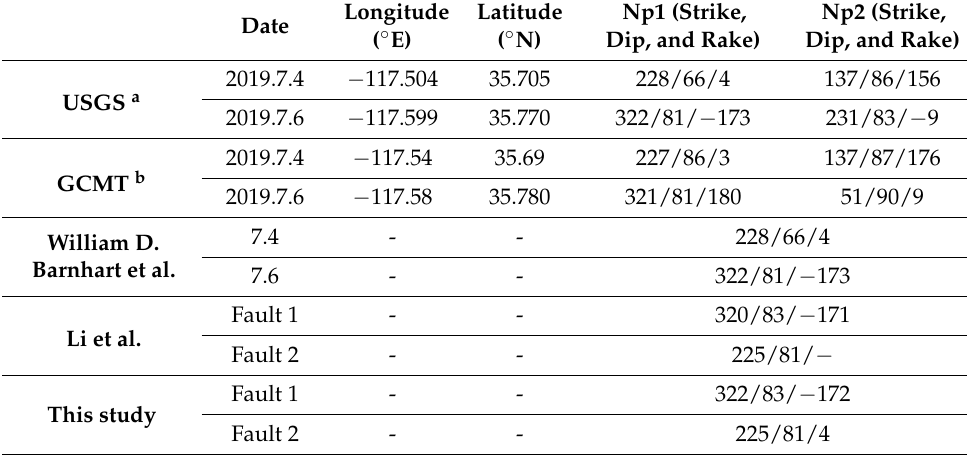
Table 1. Focal mechanism solutions for 2019 California